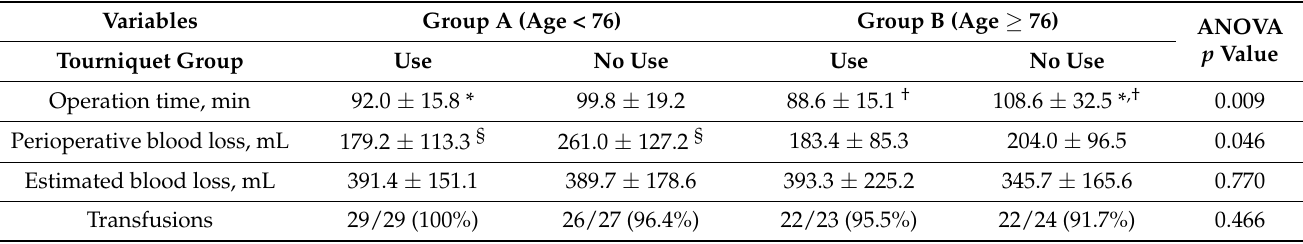
Table 2. Perioperative